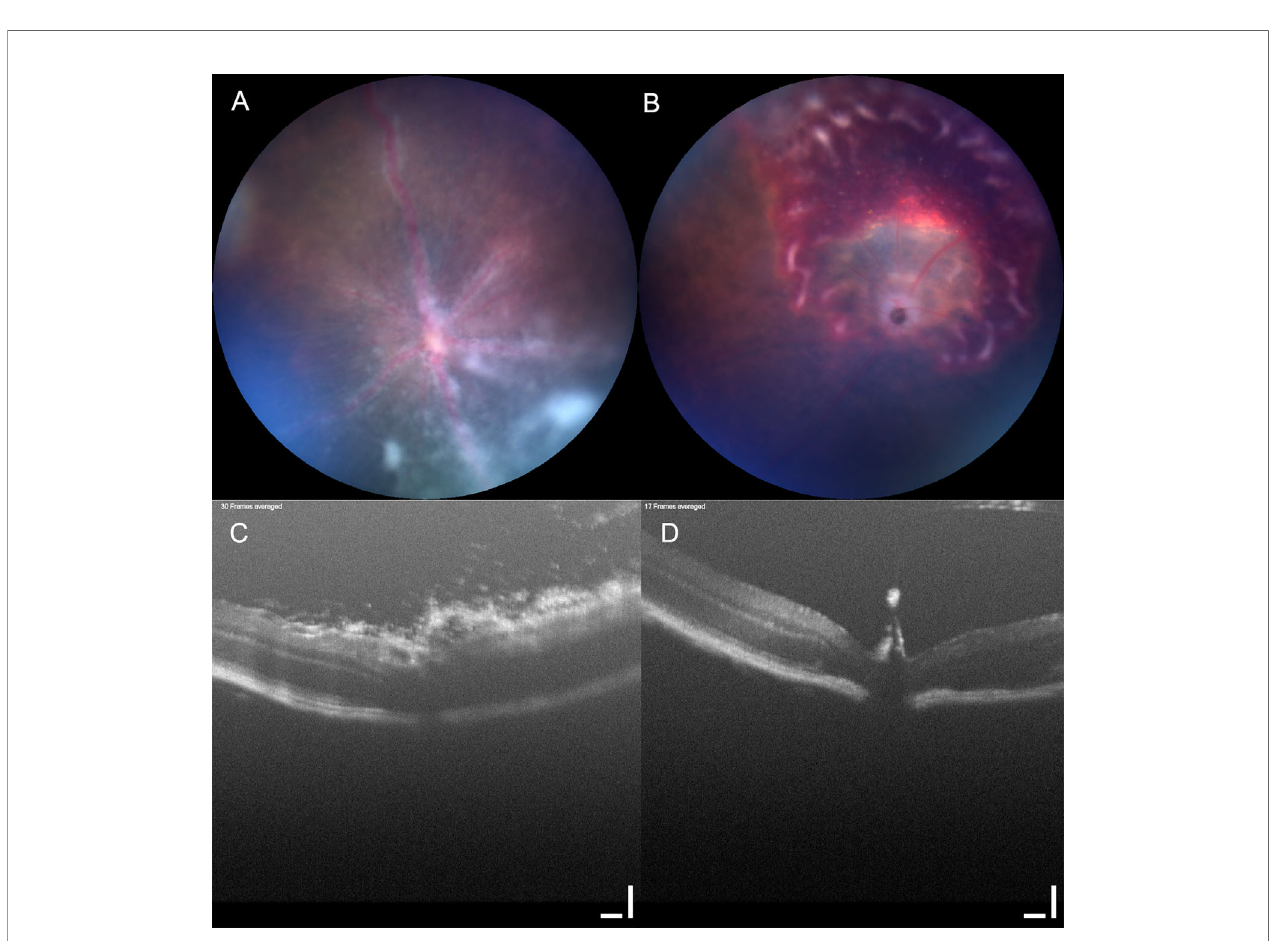
FIGURE 2 | Clinical score can be insensitive to underlying pathology. Mouse eyes imaged using Micron IV with OCT (Phoenix technology group, CA). Two mouse eyes (A, C) and (B, D) imaged using Micron IV (Phoenix technology group, CA) and assessed by fundal photography (A, B) and OCT (C, D) . Retinal photographs scored in a set of images by an observer blinded to the treatment groups, both received the same summary clinical score. Scale bar 100